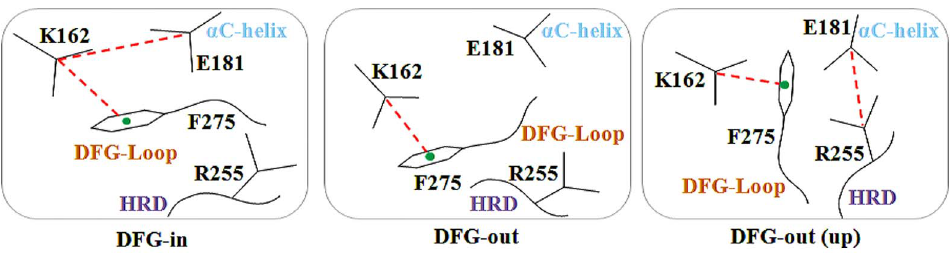
Figure 3. The three major DFG-loop conformations observed in AK. The figure displays the synergy between the salt-bridge and cation- p interactions in different DFG-conformations of AK. The interacting partners are the conserved Lys162 ( b 3), Glu181 ( a C-helix), Phe275 (DFG-loop) and Arg255 (HRD motif, the conserved triad found in the catalytic loop of most